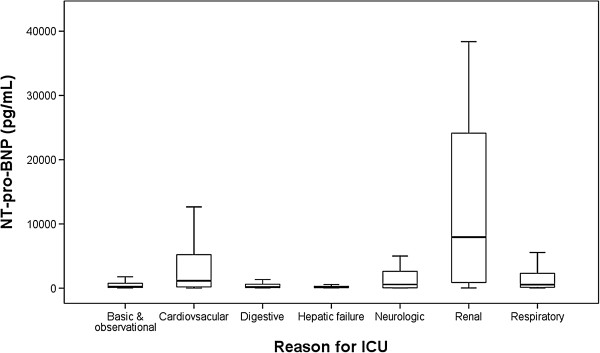
Box and whisker plots for the reason for ICU admission. NT-pro-BNP levels varied according to the reason for ICU admission.